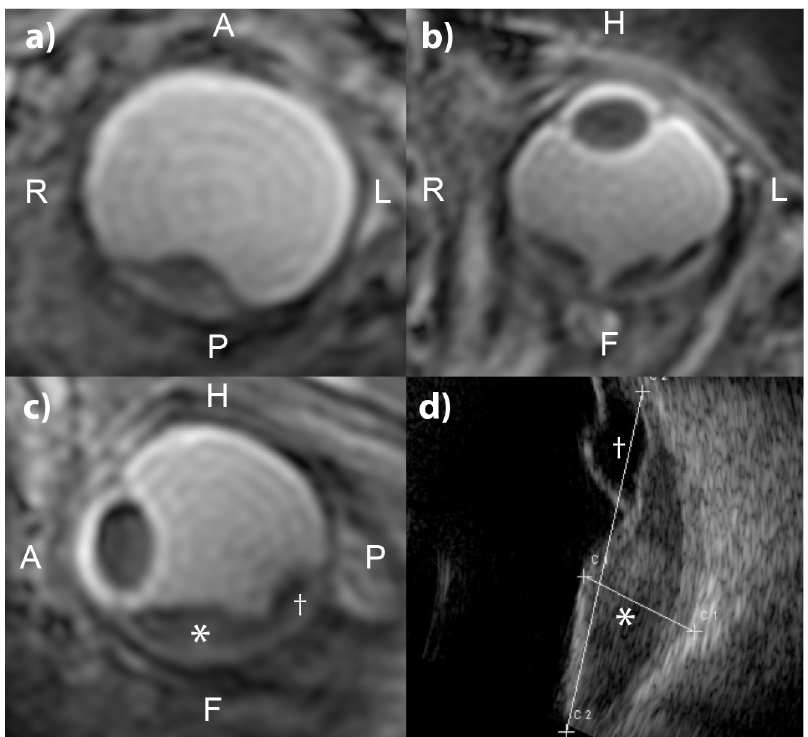
Fig 5. Reformatted high-resolution ZTEs and ultrasound frame for comparison of UM-patient 9. (a,b,c) Reformats of one T 2 -prepared ZTE scan in three orthogonal directions showing the complex three-dimensional shape of the lesion (marked by � ) and retinal detachment (marked by †). (d) Ophthalmic ultrasound is only able to provide a 2D cross-section of the lesion (tumor extent marked by c1, c2 lines with crosses).